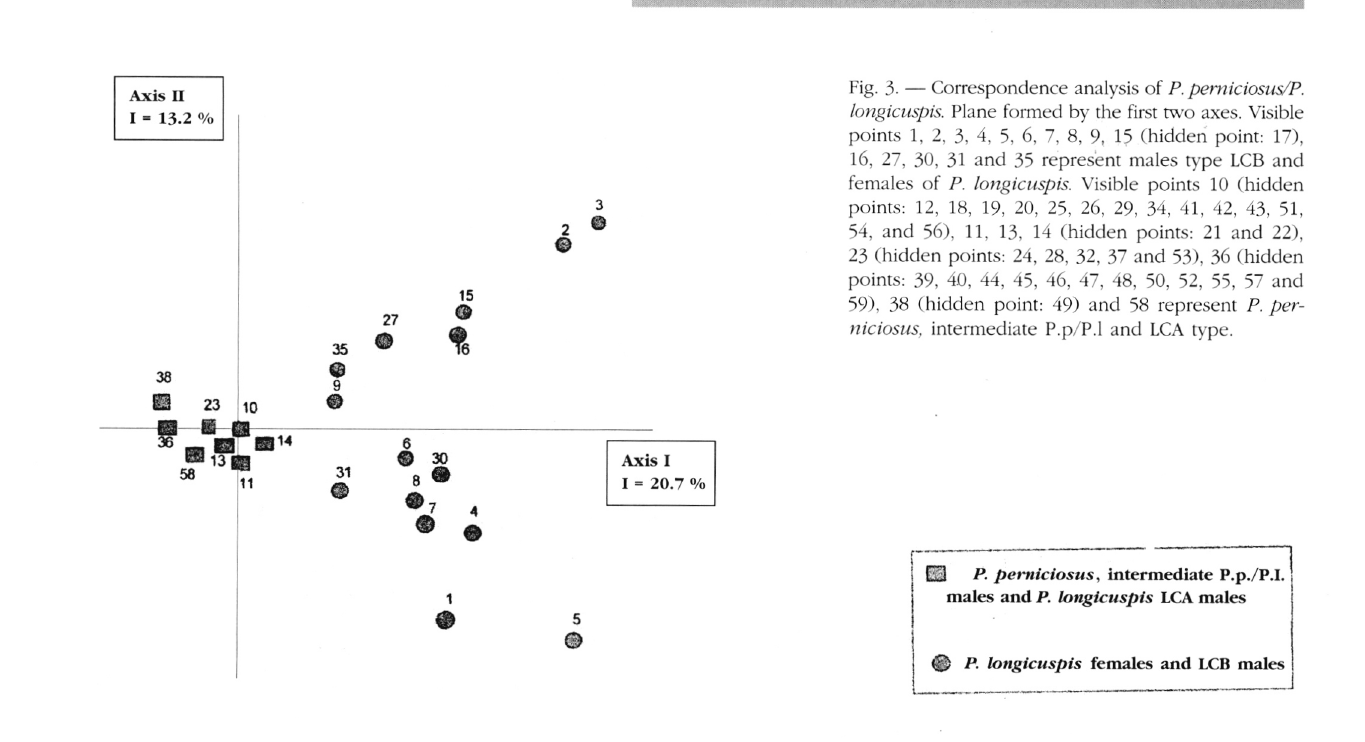
Fig. 3. — Correspondence analysis of P. perniciosus/P. longicuspis. Plane formed by the first two axes. Visible points 1, 2, 3, 4, 5, 6, 7, 8, 9, 15 (hidden point: 17), 16, 27, 30, 31 and 35 represent males type LCB and females of P. longicuspis. Visible points 10 (hidden points: 12, 18, 19, 20, 25, 26, 29, 34, 41, 42, 43, 51, 54, and 56), 11, 13, 14 (hidden points: 21 and 22), 23 (hidden points: 24, 28, 32, 37 and 53), 36 (hidden points: 39, 40, 44, 45, 46, 47, 48, 50, 52, 55, 57 and 59), 38 (hidden point: 49) and 58 represent P. per­ niciosus, intermediate P.p/P.l and LCA